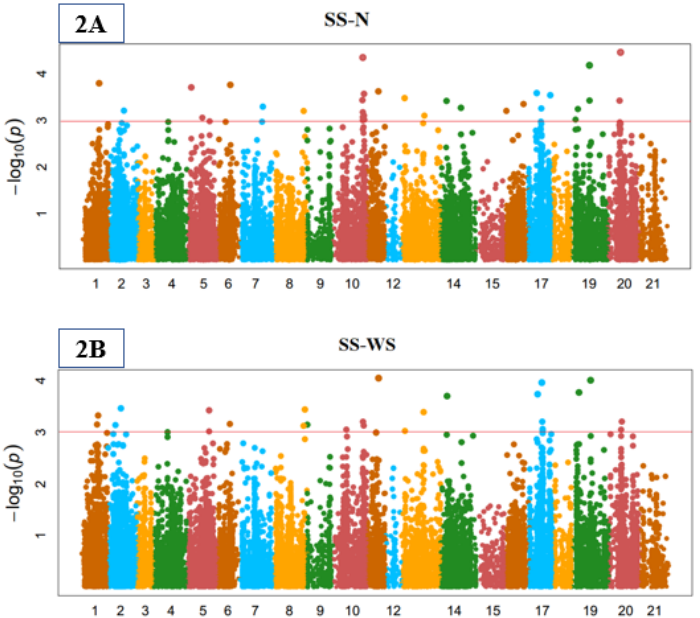
Figure 2. Manhattan plot of stomata size (SS) under normal (N) ( A ) and water shortage (WS) ( B ) conditions. Manhattan plots showing the location of significant SNPs and − log10( p ) associated with stomata size in bread wheat under normal and water shortage conditions. The red horizontal line on Manhattan plot entitles the threshold level ( p < 0.0001) of significance for SNPs with this trait.